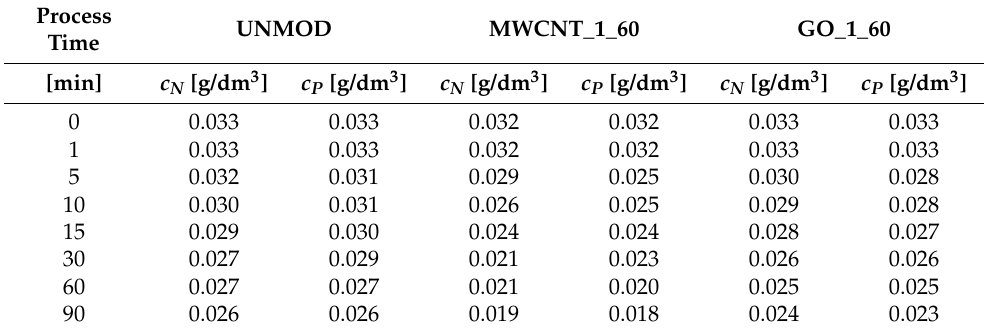
Table 3. Concentration of tetracycline in permeate and retentate during the process. Process Time